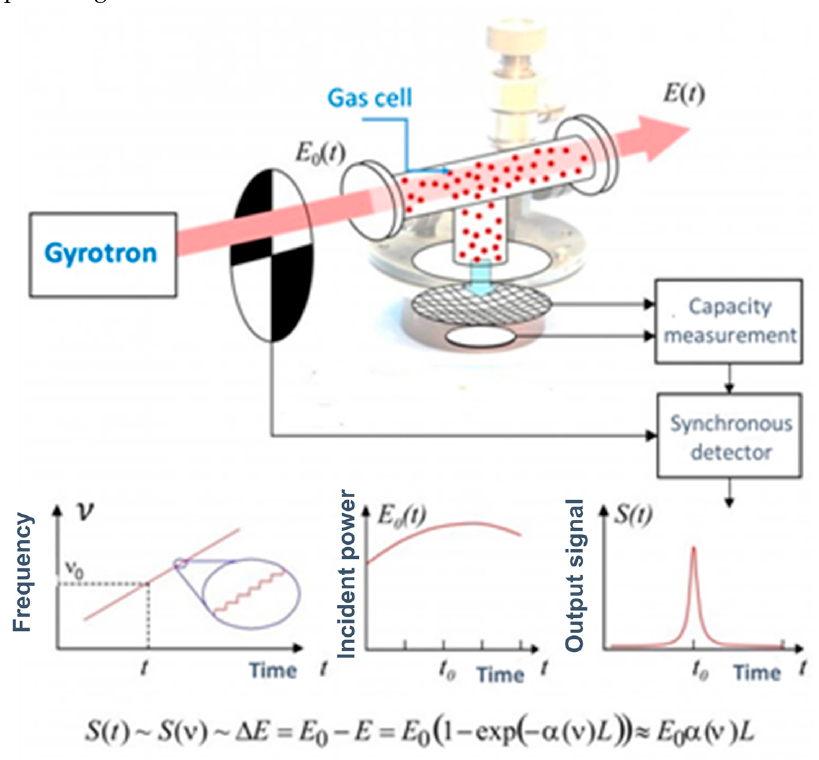
Figure 1. Principle of gyrotron-based RAD spectroscopy. The capabilities of gyrotron-based RAD spectroscopy have recently been demonstrated using an automated facility [39]. The main components of the spectrometer are shown in Figure 2. As a radiation source, a gyrotron developed at IAP-RAS and operated in the CW regime at a central frequency of about 263 GHz and an output power of up to 1 kW has been used. The radiation frequency can be continuously tuned in an interval of 0.2 GHz by vary- ing the electron beam voltage and the temperature of the cavity. The width of the radiation spectrum ∆ f is about 0.5 MHz ( ∆ f/f~10 − 6 ) and is due to the fluctuations of the accelerating potential provided by the high-voltage power supply. Using sulfur dioxide (SO 2 ) as the test gas, which has a very dense and well-studied spectrum in the mm/sub-mm range, an absorption sensitivity of the spectrometer on the order of 6 × 10 − 10 cm − 1 was achieved. These experiments have shown that an increase in the scanning radiation power of about three orders of magnitude leads to a proportional increase in the sensitivity of the RAD spectrometer [40] and therefore prove the efficiency of this so-called “power”